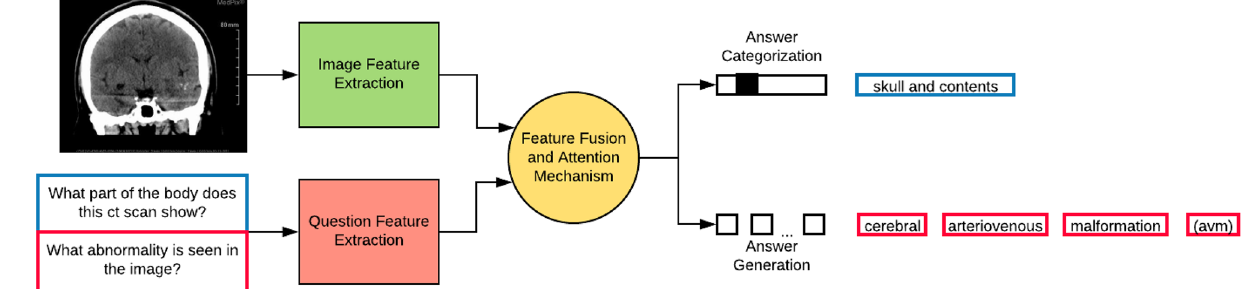
Figure 2. A high-level model design for the task of VQA. The model has four major components—image feature extraction, question feature extraction, feature fusion amalgamated with the attention mechanism, followed by answer categorization or generation depending on the